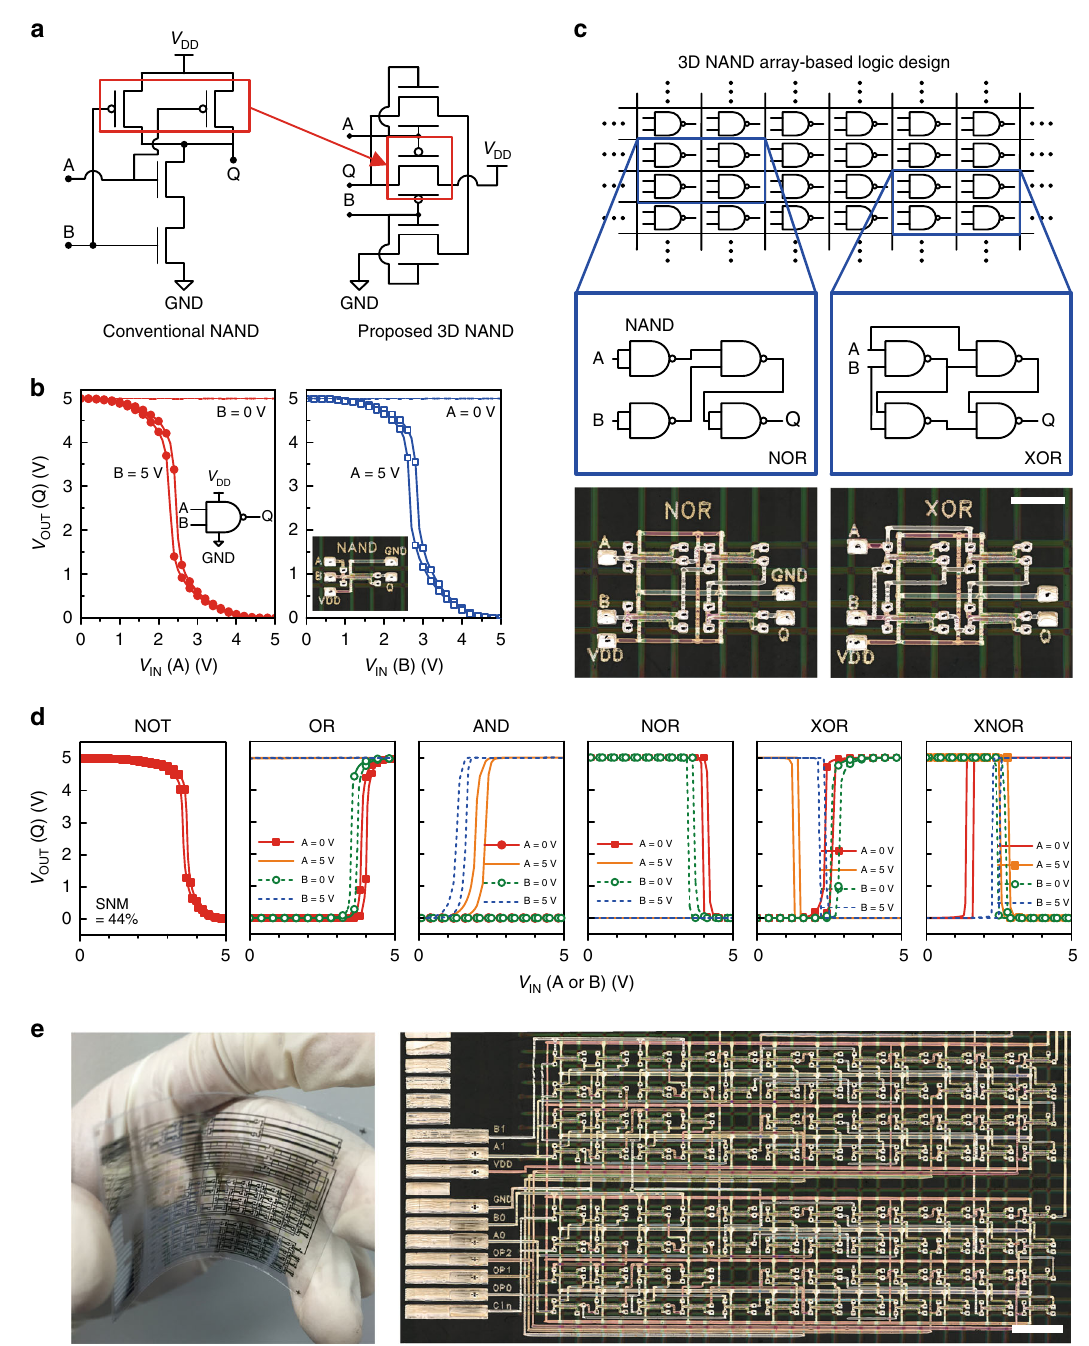
Fig. 6 3D NAND digital circuit design based on stacked 3-T dual-gate devices. a Schematic circuits of a conventional NAND gate and a proposed 3D NAND gate. b DC V OUT – V IN characteristics of a 3D NAND gate. c 3D NAND array-based logic design (scale bar is 2 mm). d DC V IN – V OUT characteristics of a 1- input NOT gate and 2-input (A and B) logic gates (OR, AND, NOR, XOR, and XNOR) implemented by interconnecting 3D NANDs. A fi xed voltage (0 or 5 V) is applied to one port while a voltage input on the other port is swept. e A large-scale fl exible logic circuitry implemented by using a 12 × 8 3D NAND gate array (scale bar is 4